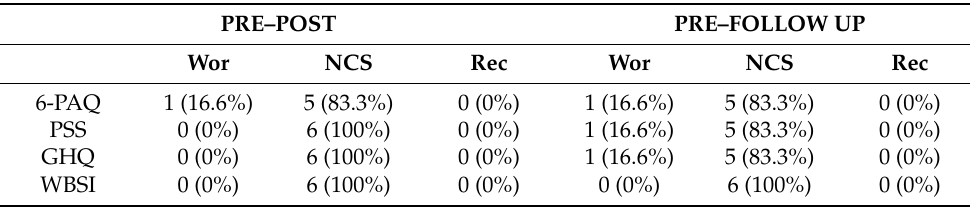
Table 6. Total and (percentage) of patients classified into each clinical significance category by the Jacobson–Truax method based on scales scores calculated across two time periods in the control group.